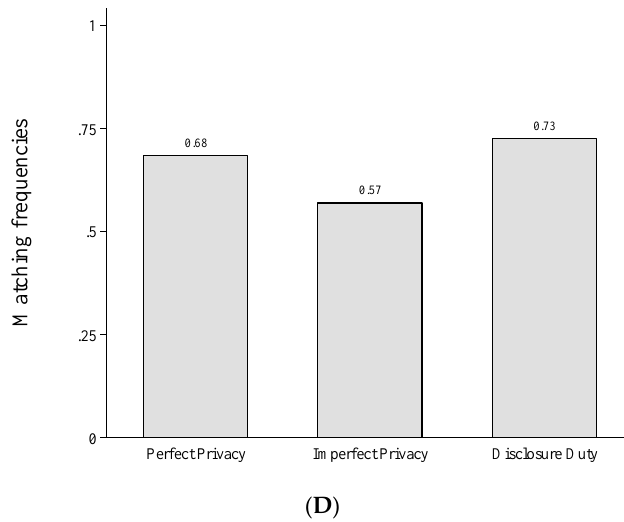
Figure 2. Testing, disclosure, matching and frequency of matches in Part 1. ( A ) Test frequencies across treatments in Part 1; ( B ) Disclosure frequencies when tested; ( C ) Matching with unknown type (# participants matching with an unknown type/# participants facing an unknown type); ( D ) Total frequencies of matches.